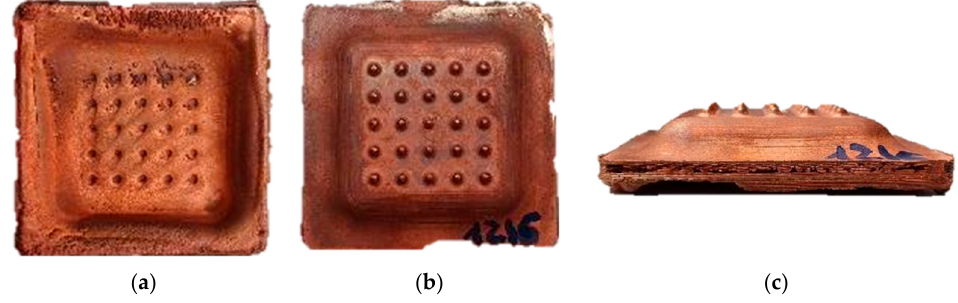
Figure 12. Finished shell ( a ) Non-functional face. ( b ) Functional face. ( c ) Thickness view.